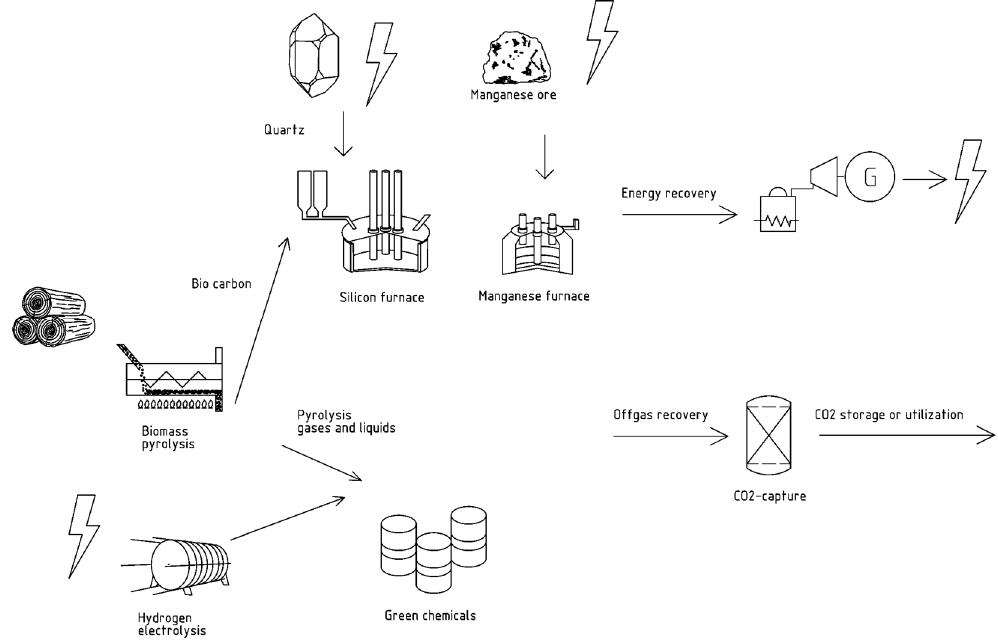
Figure 7. Opportunities for energy integration between ferroalloy production and other sustainable production processes.